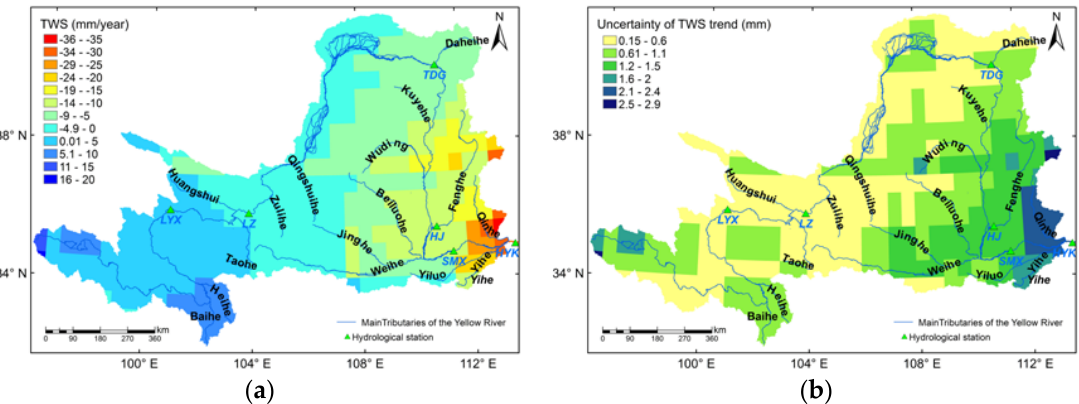
Figure 3. Distribution maps for the Sen’s slope of ( a ) TWS change trend during 2003–2015 and ( b ) their standard deviations, respectively. LYX is Langyagnxia station; LZ is Lanzhou station; TDG is Toudaogui station; HJ is Hejin station; SMX is Sanmenxia station; HYK is Huayuankou